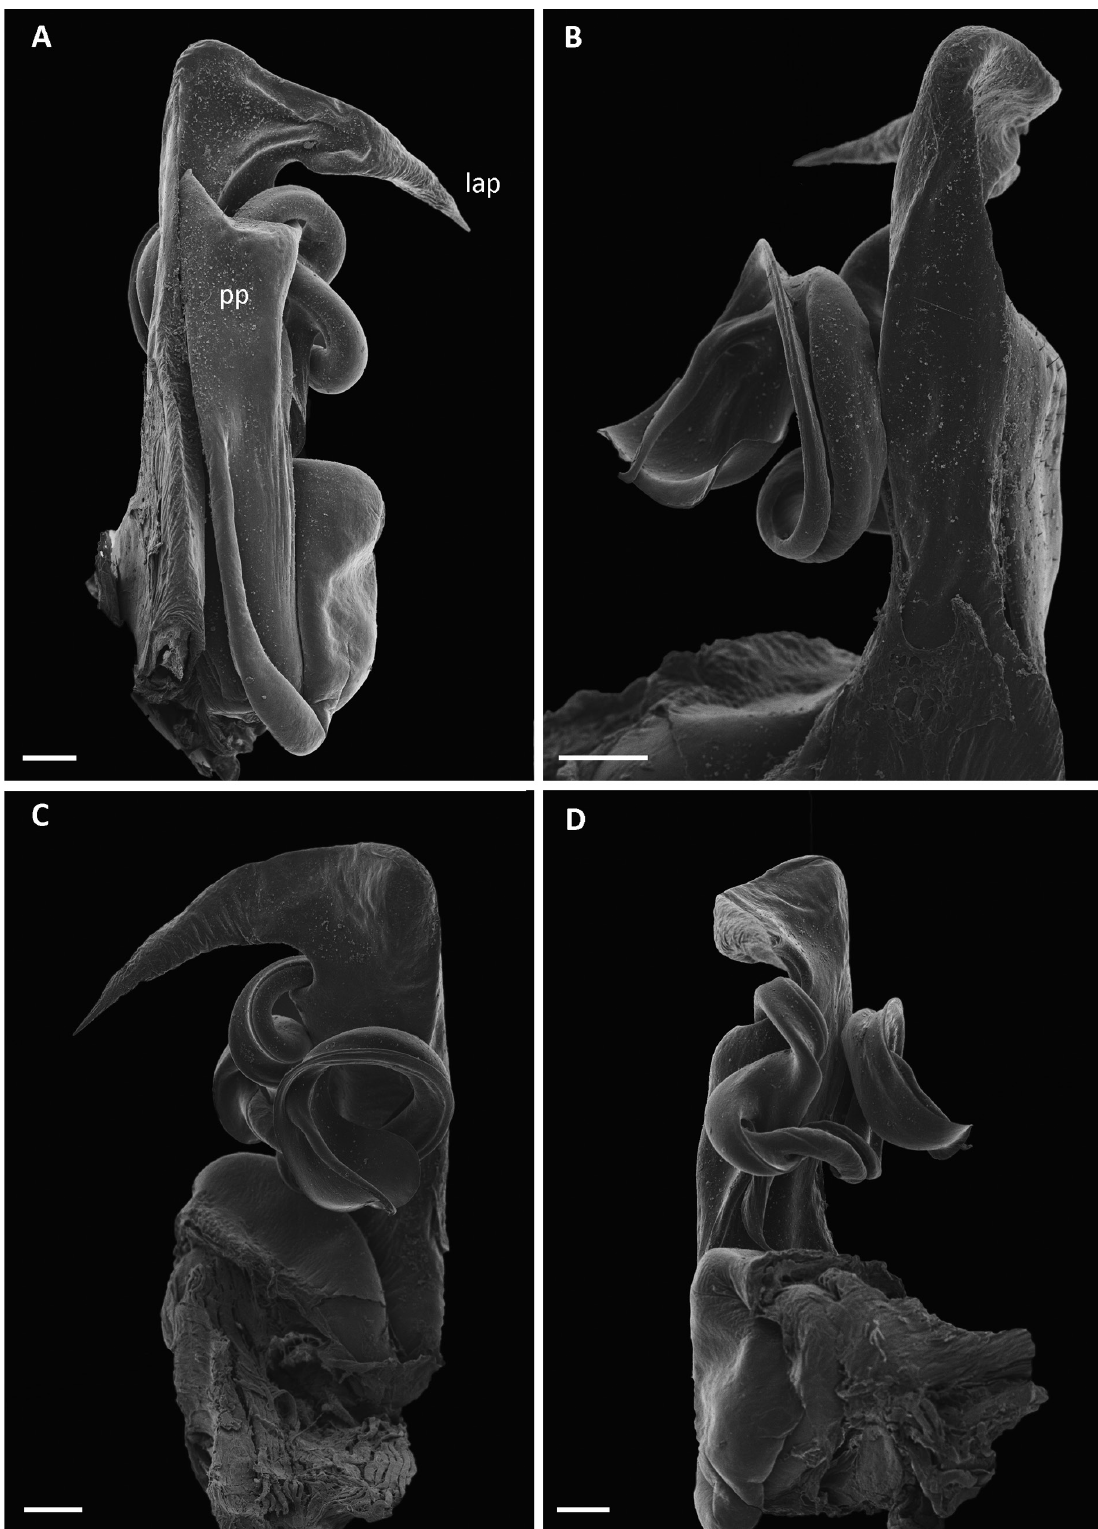
Fig. 4. Odontostreptus maroccanus (Attems, 1914), ♂, from the Asni area (NHMD 621688). Right gonopod. A . Anterior view. B . Mesal view. C . Posterior view. D . Lateral view. Abbreviations: lap = lateral metaplical process; pp = proplica. Scale bars = 0.2